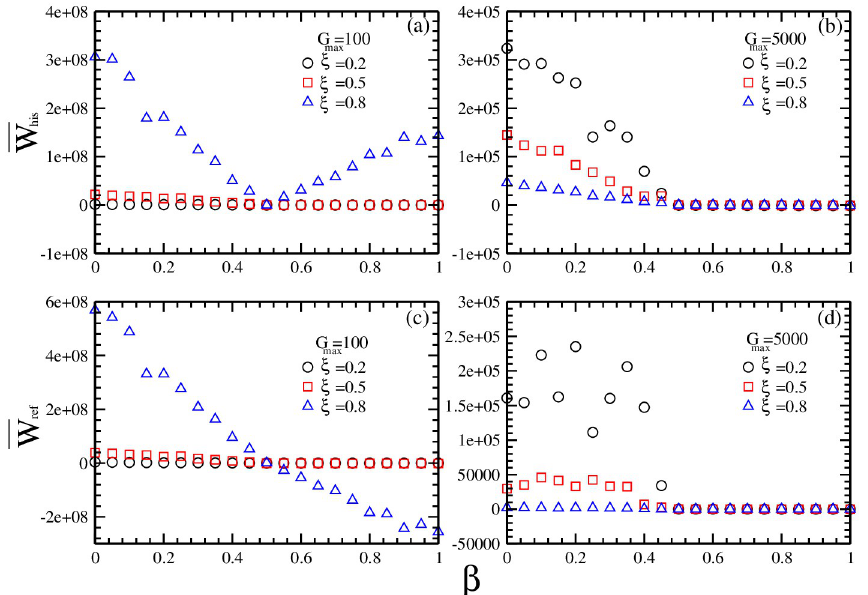
Fig 8. The average wealth � W of individuals with history-dependent strategies and the average wealth � W of his ref individuals with reference point strategies as a function of market impact β for different combinations of maximal risk tolerance G max of reference point strategies and the ratio ξ of individuals with reference point strategies. (a) � W for G = 100 and ξ = 0.2 (circles), 0.5 (squares), 0.8 (triangles); (b) � W for G = 5000 and ξ = max max his his 0.2 (circles), 0.5 (squares), 0.8 (triangles); (c) � W for G max = 100 and ξ = 0.2 (circles), 0.5 (squares), 0.8 (triangles); (d) ref � W for G = 5000 and ξ = 0.2 (circles), 0.5 (squares), 0.8 (triangles). Other parameters are: the population size max ref N = 5001, the memory size m = 3 and m 0 = 10, the updating threshold of history-dependent strategies S th = 0, the maximum drift of history-dependent strategies ε = 0.1, the liquidity l ¼ N , the constant a ¼ 10 , minimum and 10 N maximum shares holding k = -1, k = 1. The initial conditions are: an individual’s risk tolerance G is uniformly min max i 2 [0, G ], an individual’s initial reference point p ref is uniformly distributed distributed within the range of G i max i